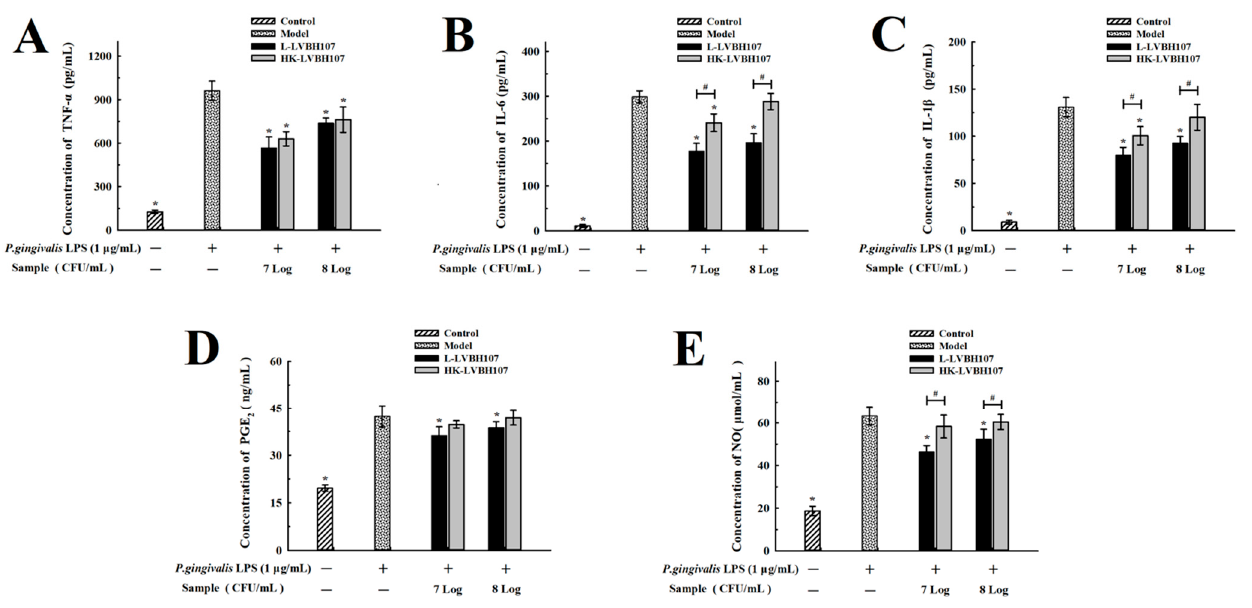
Figure 5. Effect of L. mesenteroides LVBH107 on proinflammatory cytokines in RAW264.7 cells. RAW264.7 cells were treated with live or heat-killed L. mesenteroides LVBH107 and stimulated with P. gingivalis LPS for 24 h. The levels of TNF- α ( A ), IL-6 ( B ), and IL-1 β ( C ) were assessed with ELISA kits. The levels of PGE 2 ( D ) and NO ( E ) were assessed with assay kits. * p < 0.05, compared to P. gingivalis LPS group; # p < 0.05, comparison between live and heat-killed L. mesenteroides LVBH107. Actual p -values are shown in Tables S2–S7.